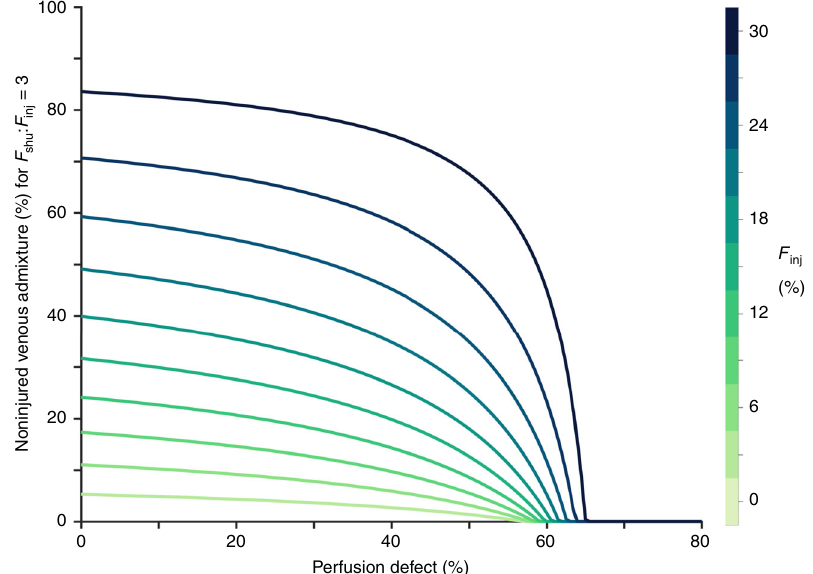
Fig. 5 Contribution of ventilation-perfusion mismatch in the noninjured lung. Each line represents the fraction of venous admixture in perfusion from the noninjured lung required to produce a ratio of total shunt fraction ( F shu ) to injured fraction ( F inj ) of 3, assuming complete shunt in the injured lung compartments, and assuming impairment of hypoxic pulmonary vasoconstriction everywhere in the lung. Color indicates the fraction of injured lung ( F inj ). Baseline perfusion gradient was 30%, and injury was focused in the lower lung zone. Note that F inj = 0% is not explicitly shown.